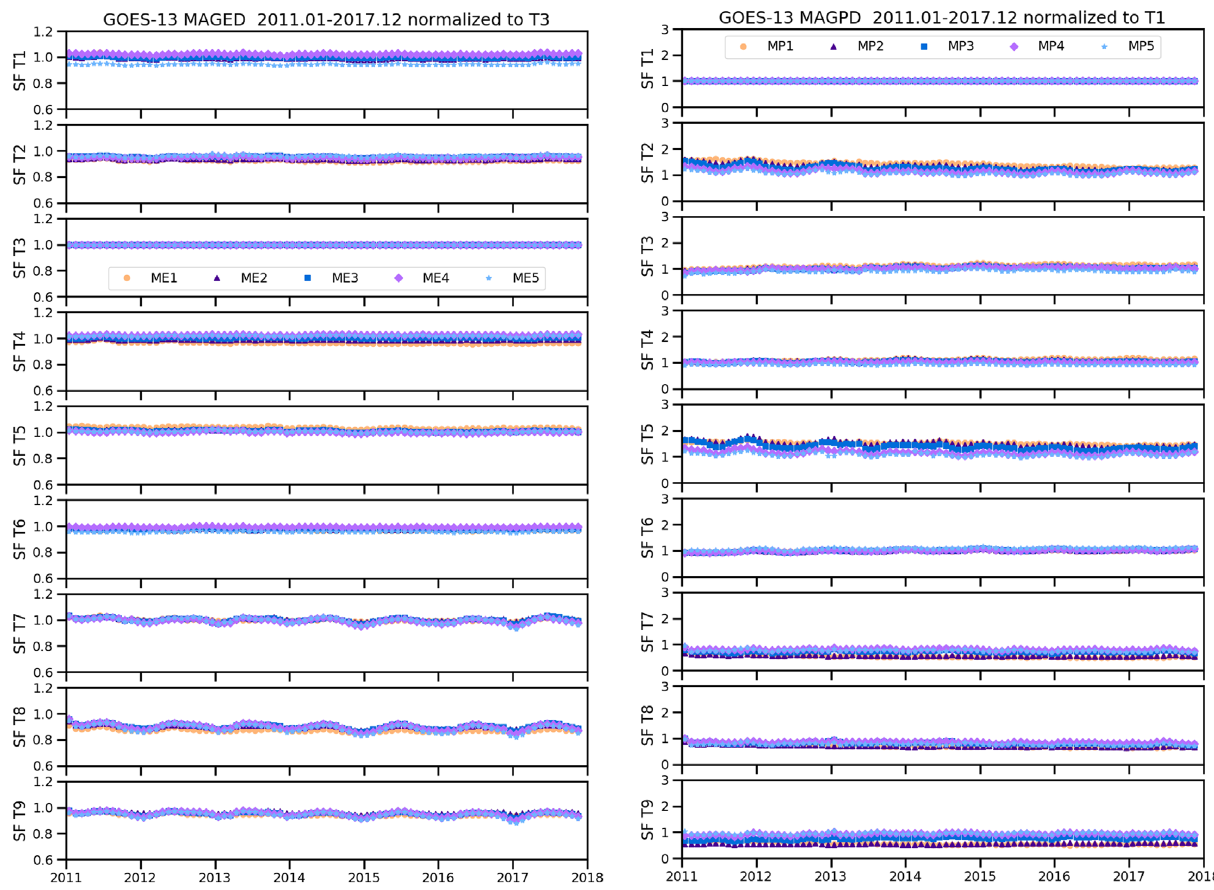
Fig. 7. Intra-calibration scale factors (SFs, unitless) for GOES-13 MAGED (left) and MAGPD (right), 2011 – 2017. Each panel illustrates the SFs for all fi ve energy channels from one